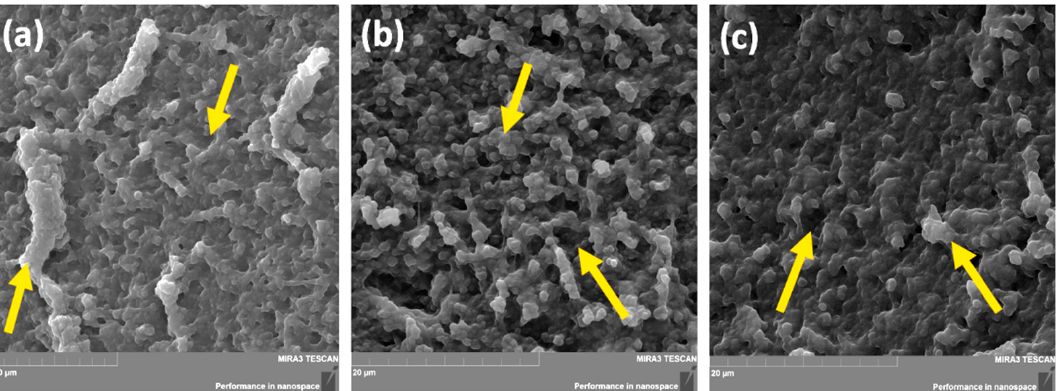
Figure 5. SEM microphotography of the SA/PVA matrix (M) ( a ), with the thermo-sensitive carrier– salicylic acid system M-T-SA ( b ) and pH-sensitive carrier–salicylic acid system M-pH-SA ( c